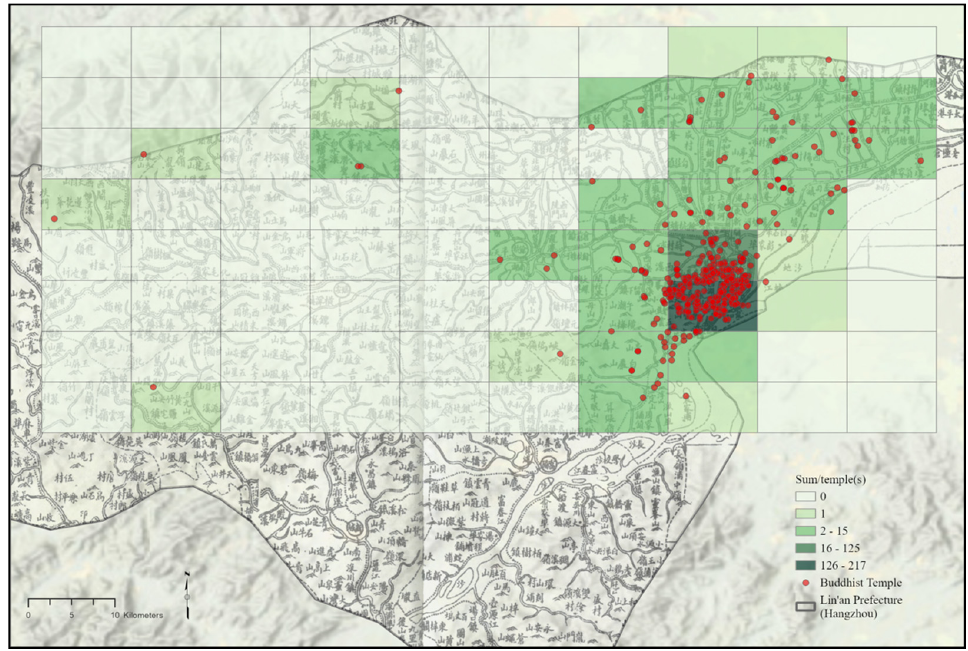
Figure 3. Quadrat analysis (59 square kilometers per cell) of Buddhist temple distribution recorded in the Xianchun Lin’an zhi 咸淳臨安志 ( Records about Lin’an from the Xianchun Reign ). Building upon the results from ANN that the data points are clustered, we can see that the temples are clustered within the darkest cells from the image above. Second, we calculate the frequency of points in all cells. This frequency value, VMR (variance (cid:3398) mean ratio), represents the variability of data points in cells in terms of the observed frequency and the mean frequency. Then, we calculate the pattern of data distribution based on the numbers in each cell.